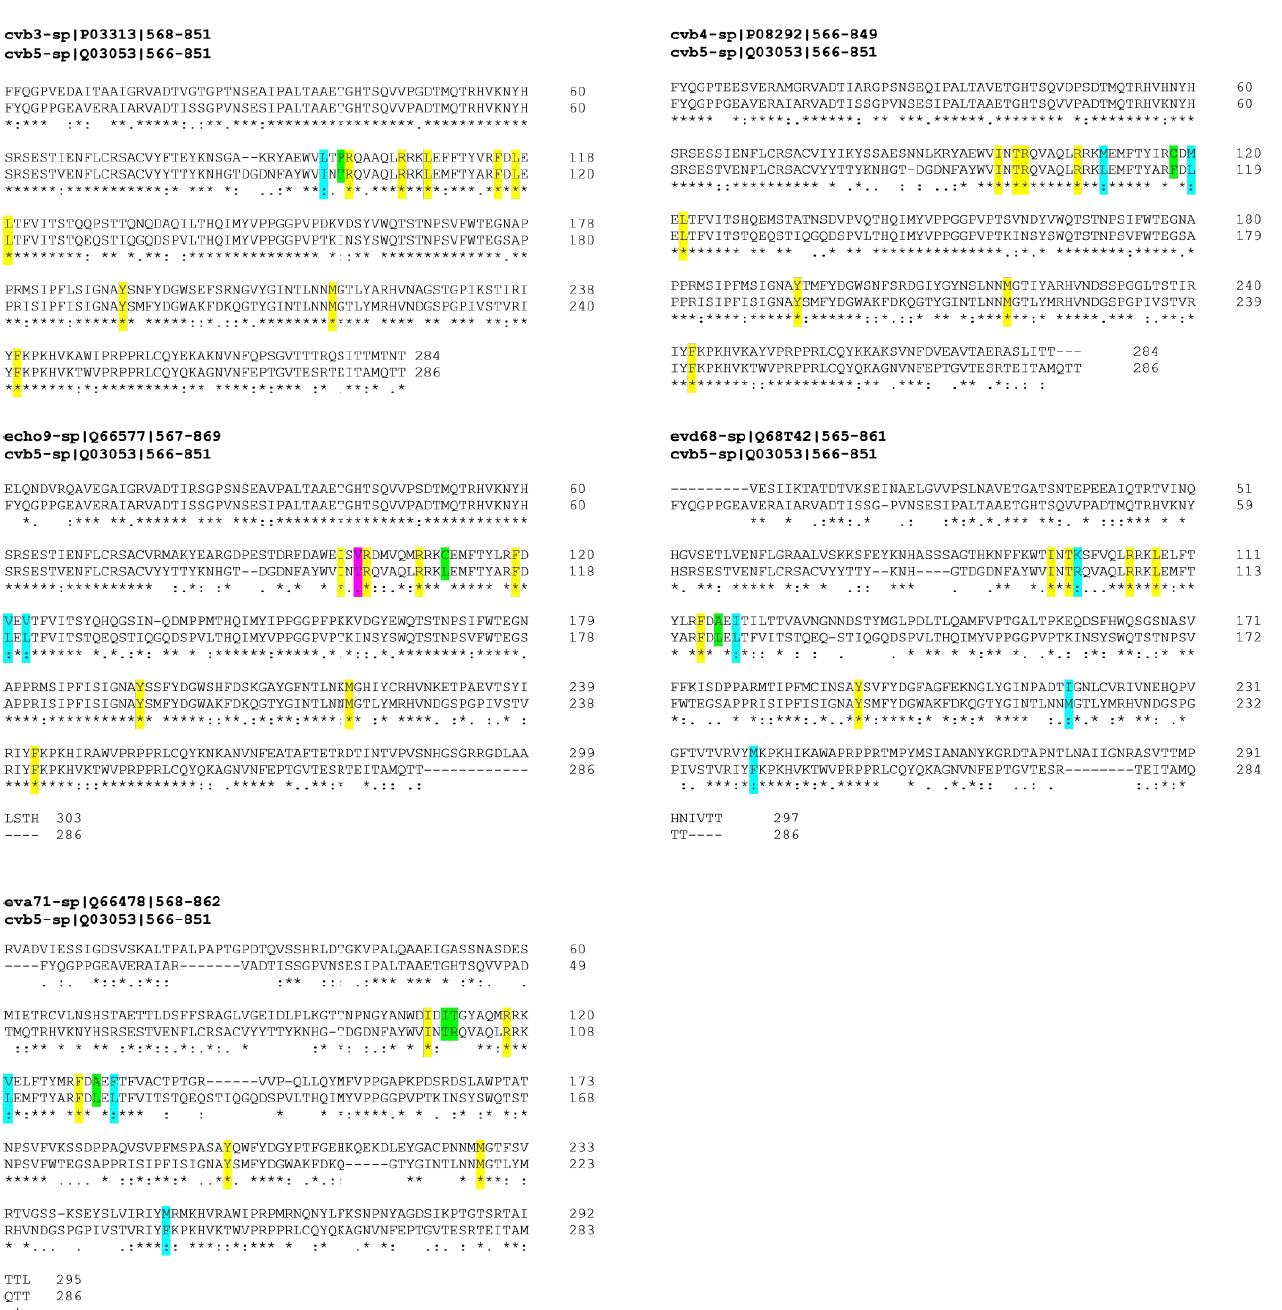
Figure 4. VP1 sequence of analyzed EVs, aligned with reference CVB5-VP1. Key amino acids for target-molecule binding arehighlighted with different colors for amino-acid affinities. * (asterisk) and yellow indicate positions with a single, fully conserved residue; (colon) and cyan point out conservation between groups of similar properties; (period) and magenta indicate conservation between groups of weakly similar properties; no symbol and green stand for different residues with no similar properties.